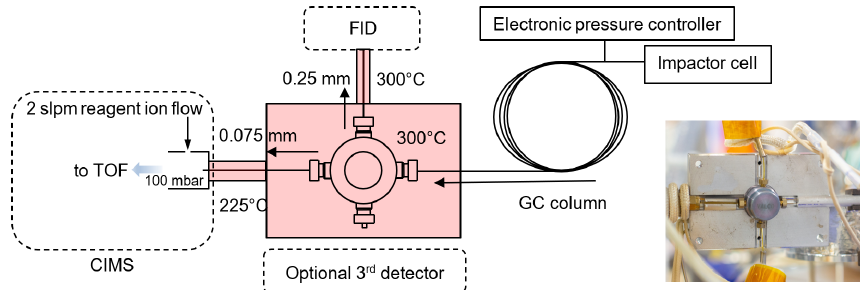
Figure 1. Schematic of the TAG CIMS/FID interface, with a photo inserted. Details of each instrument are simplified. Restrictive capillaries to each detector are used to balance flows to each detector due to differences in pressure (dimensions and temperatures shown).